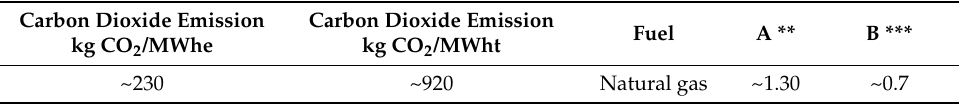
Table 4. CO 2 emission factors and adapting coefficients applied to the case of CHP fed by lignocellulosic biomass (IPCC 2014 [35] *). Carbon Dioxide Emission Carbon Dioxide Emission Fuel A ** B *** kg CO 2 /MWhe kg CO 2 /MWht ~230 ~920 Natural gas ~1.30